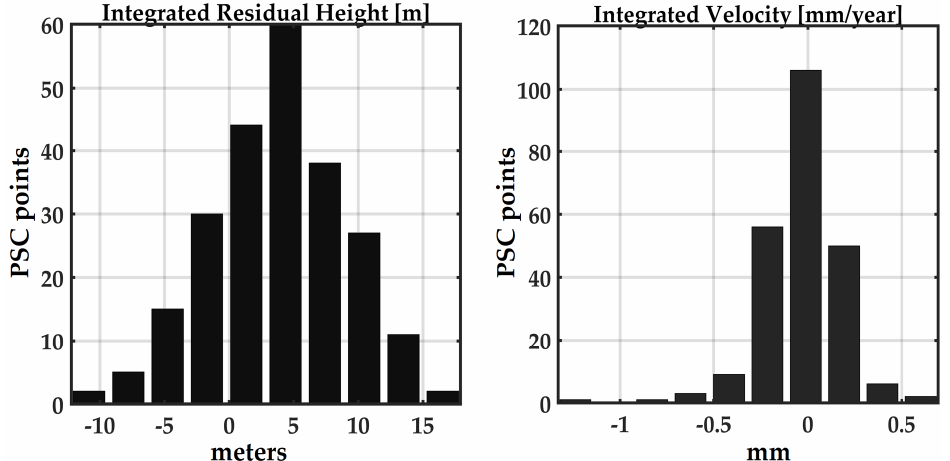
Figure 9. Estimated residual height histogram (left) and estimated velocity histogram (right) during APS calculation. Histograms represent the distribution of the integrated residual height and integrated velocity for each point with respect to the reference point (example of descending VV data). values based on the maximum allowed building height, and also that the points are stable (zero velocity), and by extension the reference point too. Figure 10 shows the temporal coherence of PS points after removing the estimated APS.